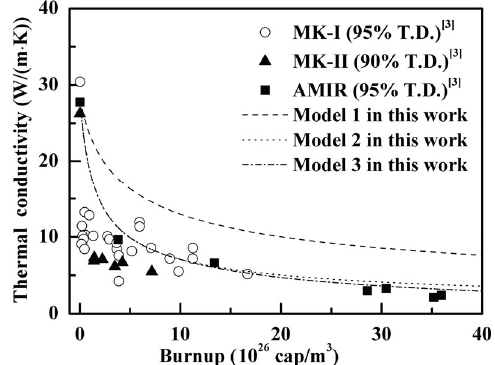
Fig. 5 Burnup dependence of the thermal conductivities predicted by all the models in this work with comparison to the experimental data by Maruyama et al . [3] which are labeled by the facilities where the samples were